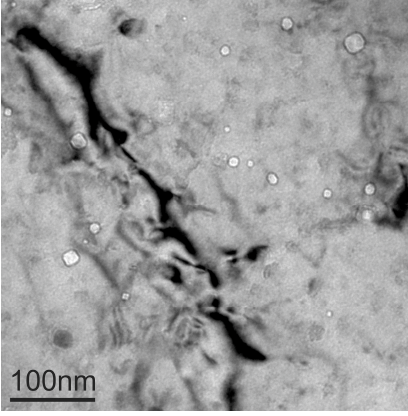
Figure 1. Bright field TEM observation of micro-voids in Eurofer97 steel neutron irradiated at 350 °C to 16 dpa.